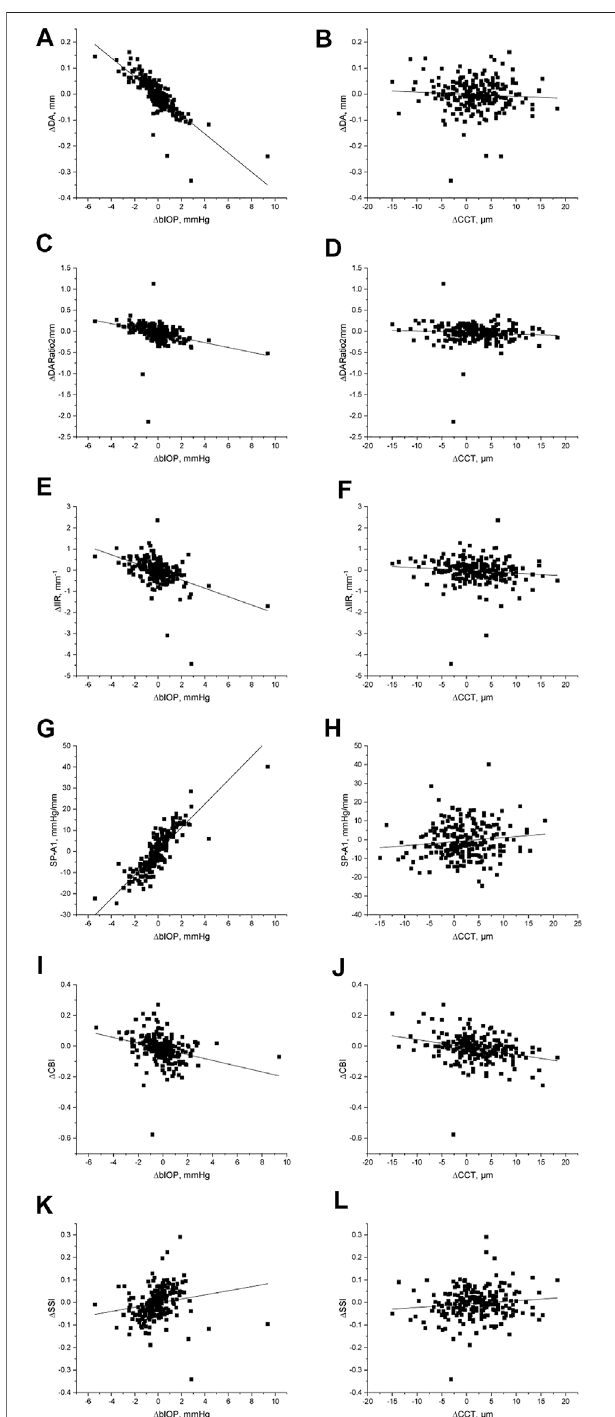
FIGURE 2 | Scatter diagram and linear fi t for the differences in DCR parameters recorded before and after the mydriasis test and the corresponding differences in bIOP and